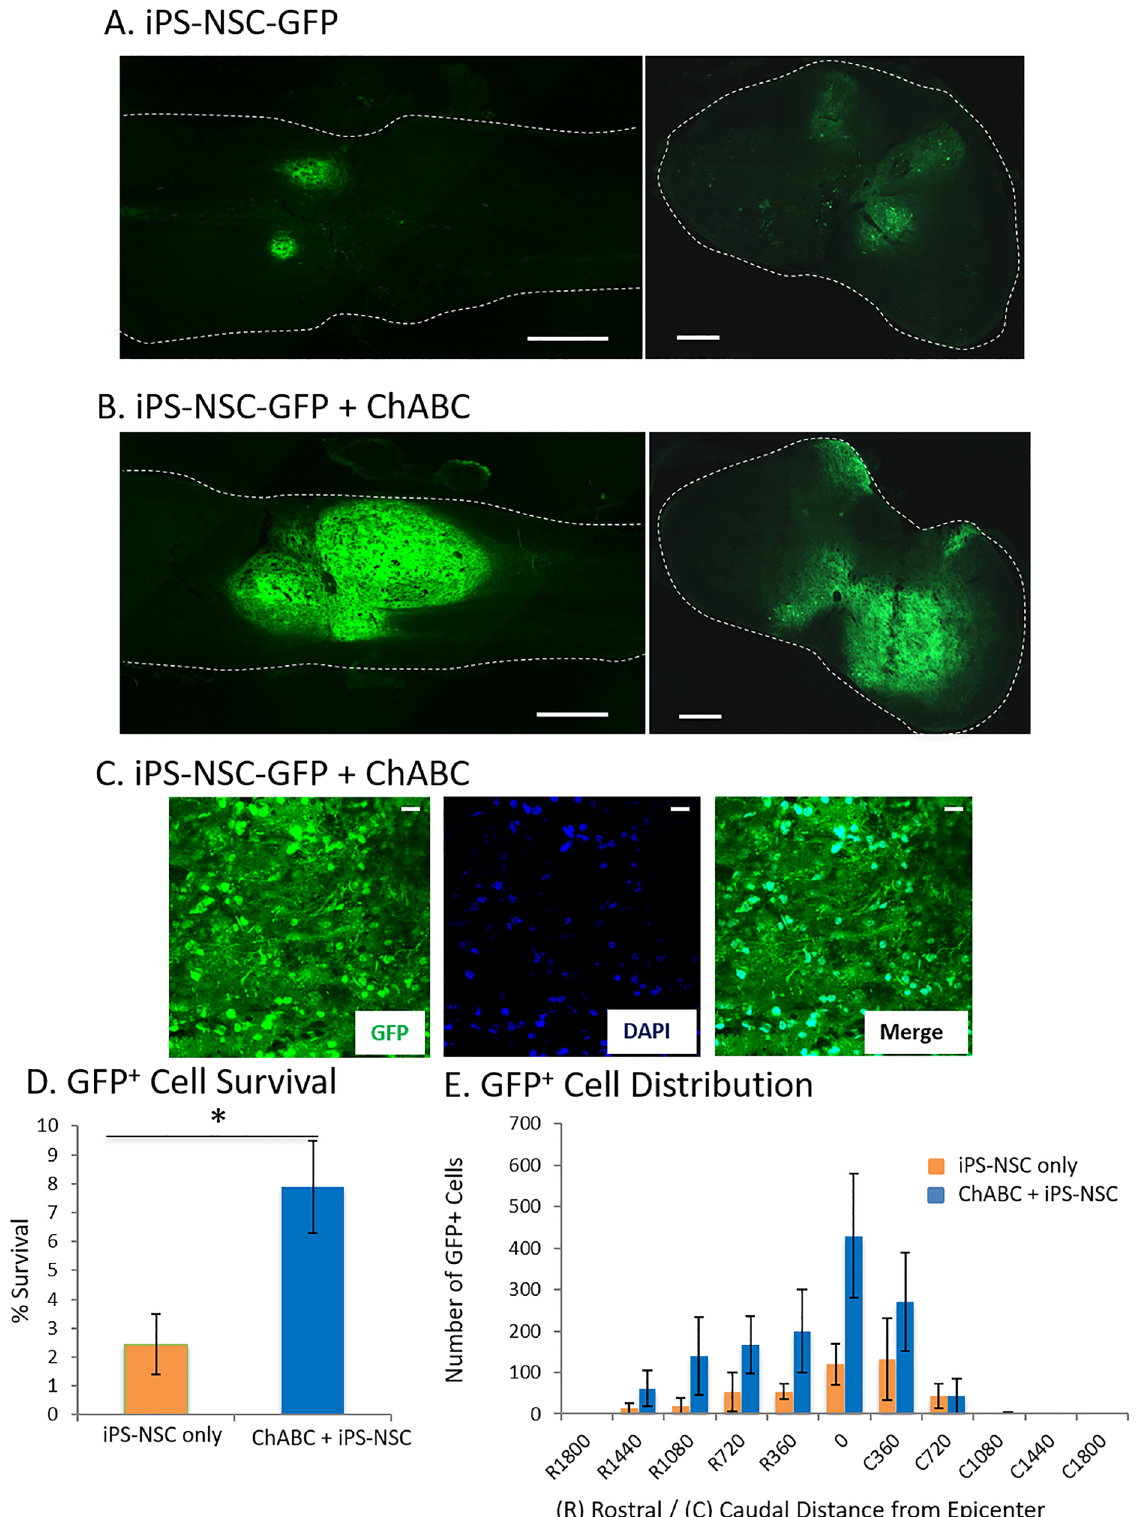
Fig 2. ChABC pretreatment enhanced transplanted iPSC-NSC survival. (A,B,C) Representative longitudinal and axial sections of injuredspinalcords 8 weeks after transplant (16 weeks after injury). Scale bar represents200 μ m in A and B. Scale bar